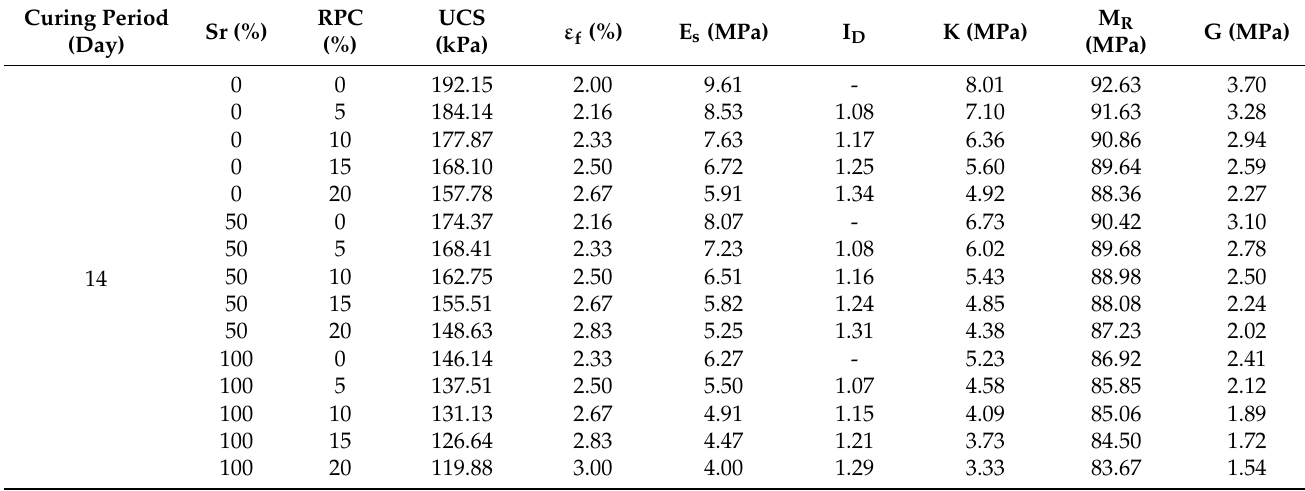
Table 5. Geotechnical properties of Group B of the